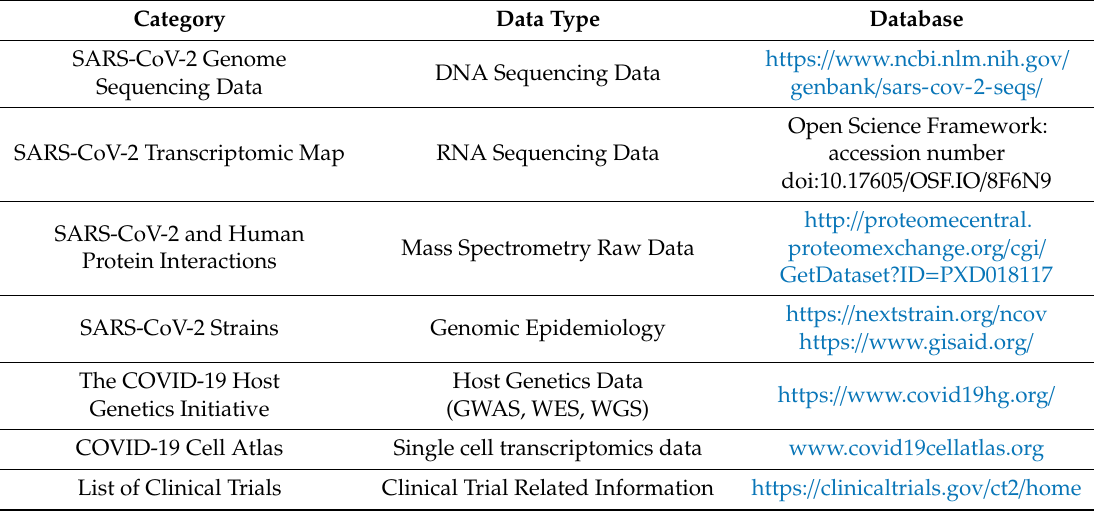
Table 1. Resources related to genomics, transcriptomics and